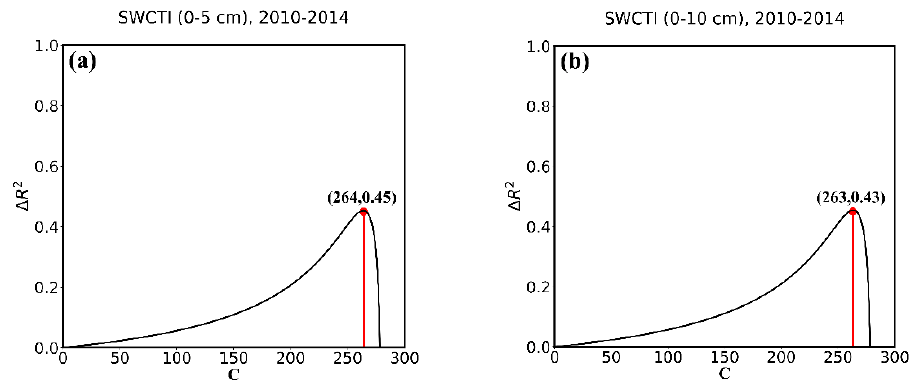
Figure 8. Curves of ∆R (cid:2870) with respect to the variable C at ( a ) 0–5 cm soil depth and ( b ) 0–10 cm soil depth.